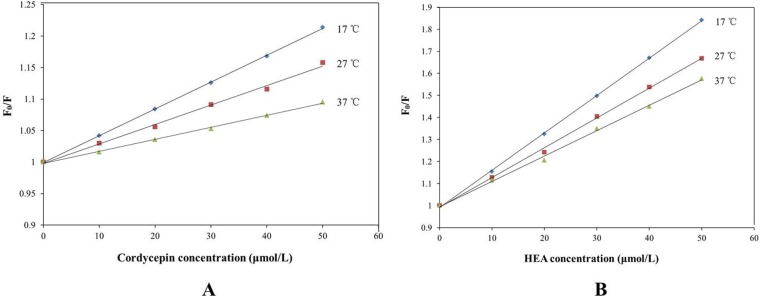
A: Stern–Volmer plot for cordycepin–HSA at different temperatures; B: Stern–Volmer plot for HEA–HSA at different temperatures.